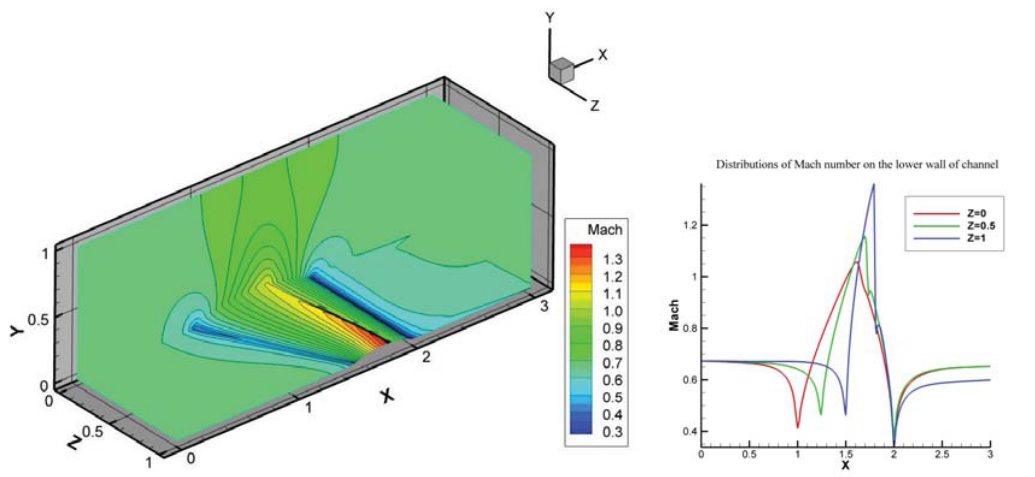
Figure 10: Inviscid compressible flow around the S WEPT W ING in the channel: Mach number iso- lines at M 1 = 0 . 675 (left) and distributions of Mach number on the lower wall in the slides (right) – WLSQR scheme by J. Holman [3], IBC A , a structured non-orthogonal grid with 180 × 35 × 35